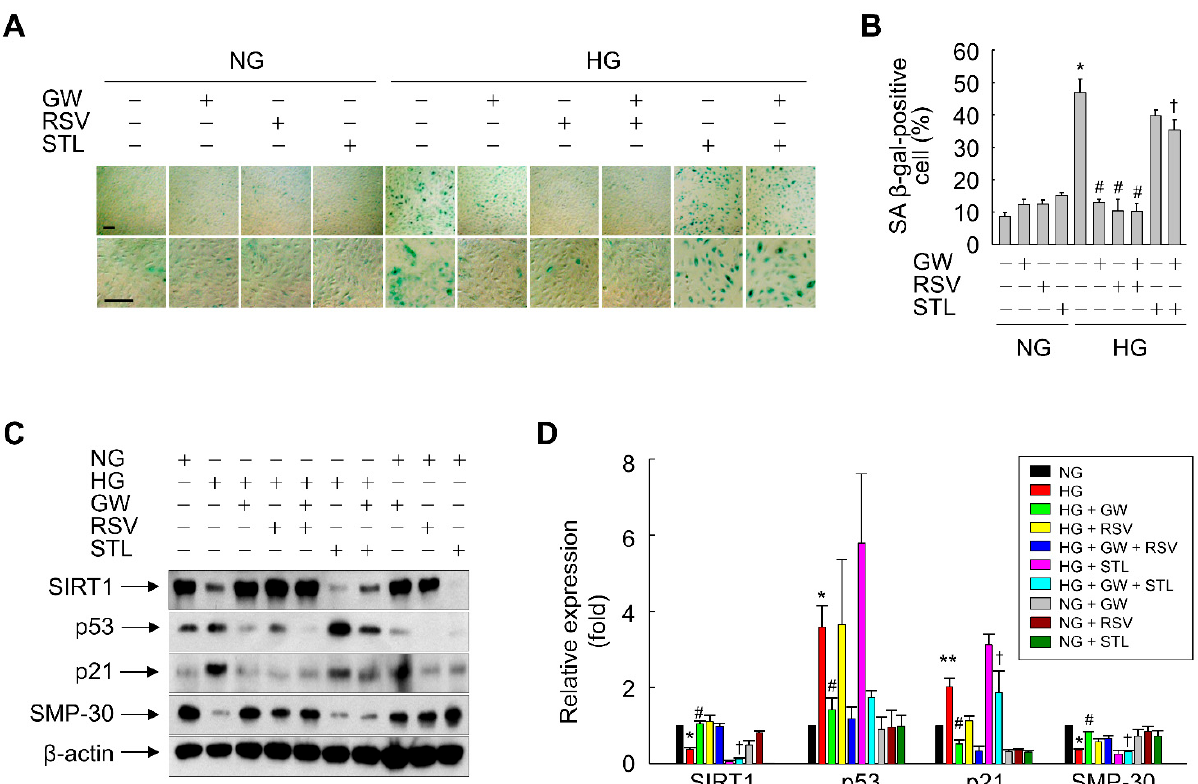
Figure 9. SIRT1 mediates the effect of PPAR δ on HG-triggered senescence of ARPE-19 cells. ( A , B ) Cells pretreated with (+) or without ( − ) resveratrol (RSV) or sirtinol (STL) for 30 min were incubated in the presence of 100 nM GW501516 (GW) or a vehicle (DMSO). After incubation for 24 h, cells were exposed to NG (5.6 mM) or HG (30 mM) for 48 h and then senescent cells were detected by SA β -gal staining ( A ) and quantified ( B ). Scale bars indicate 100 µ m. ( C , D ) Cells treated as described above were exposed to NG or HG for 48 h and then protein expression was analyzed by Western blotting ( C ) and quantified ( D ). Data are expressed as means ± S.E. ( n = 3 for Western blotting and n = 6 for SA β -gal staining). * p < 0.01, ** p < 0.05 compared with the NG-treated group. # p < 0.01 compared with the HG-treated group. † p < 0.01 compared with the GW-treated group.